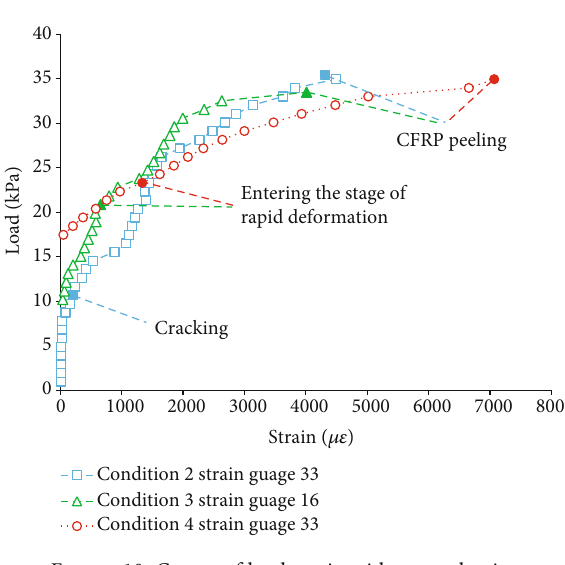
Figure 10: Curves of load-strain with Table 4: Comparison of statistics for di ff erent conditions. Condition